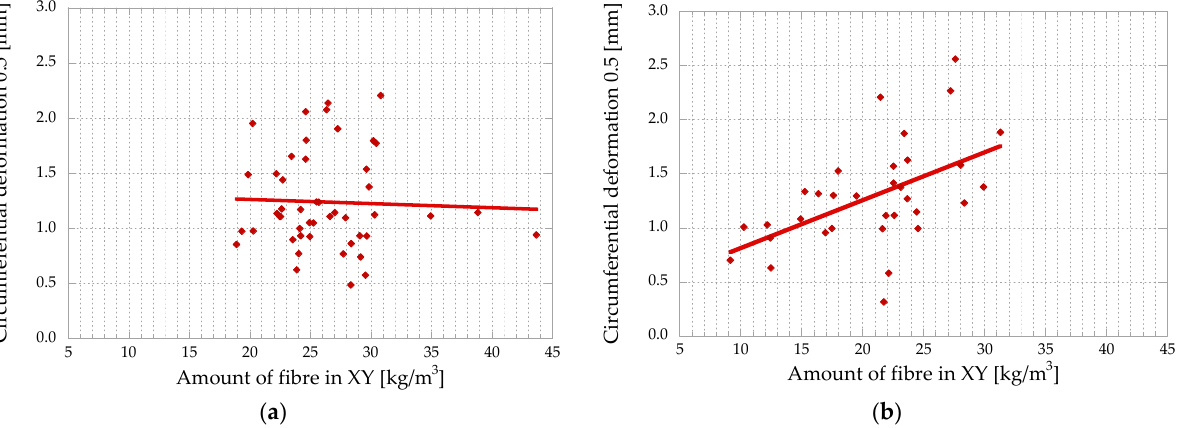
Figure 17. Correlation between circumferential deformation vs. fibre quantity in the XY plane for BV ( a ) and BH ( b ).